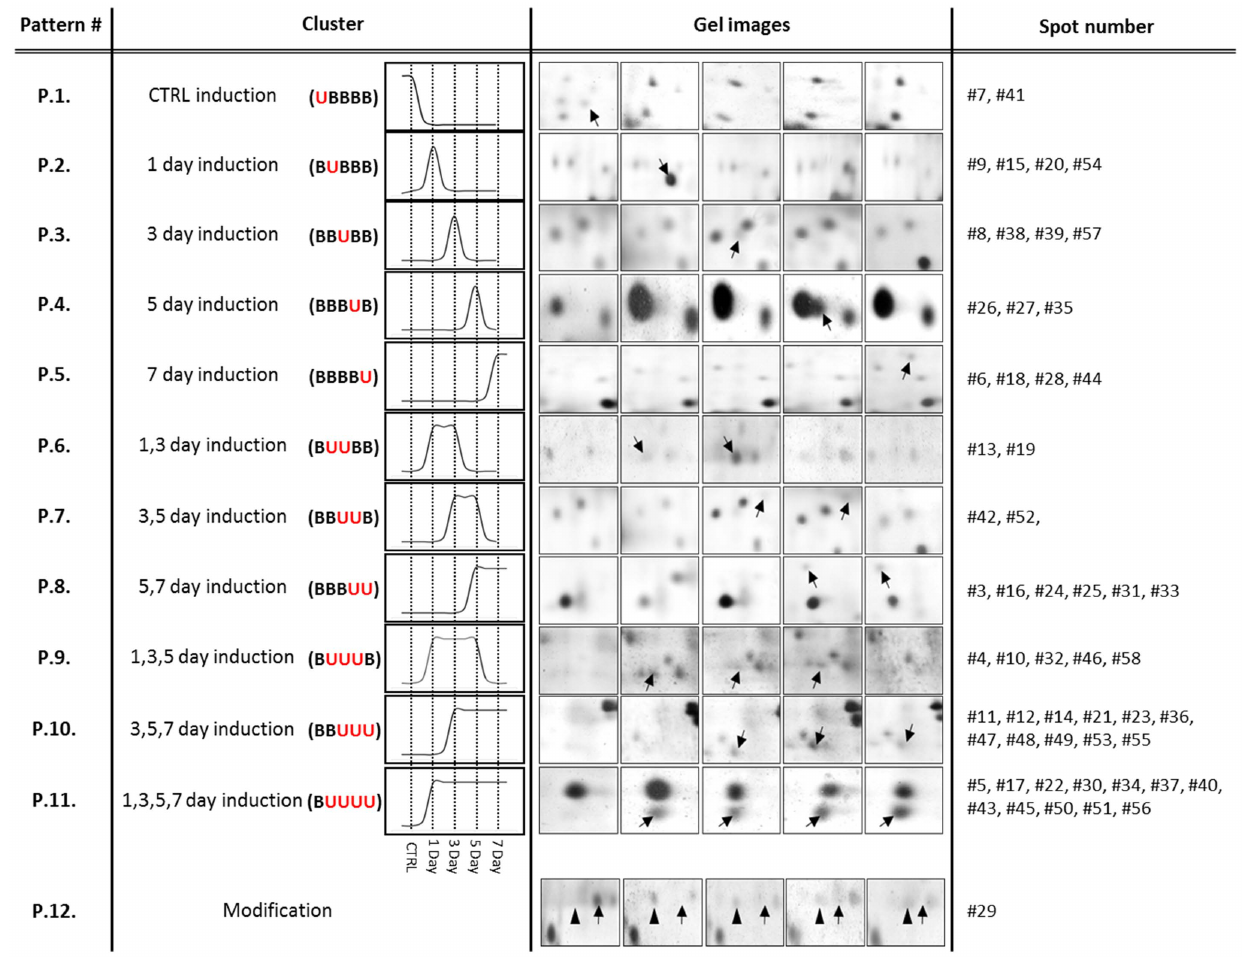
Figure 4. Categorization of 58 spots based on temporal expression profiles. Fifty-eight spots were grouped based on their temporal expression patterns following spot analysis for each time point (B: basal expression; U: up-regulation; M: modification). All identified spots in 2-DE gel are categorized into 12 patterns based on their expression profiles (p , 0.05, one-way ANOVA). The examples of spots corresponding to the expression pattern or profile were shown. Black arrows indicate up-regulated spots at each time point. In the pattern # 12, black arrows indicate spot was shifted into a different pH location on gels as the culture progresses. Arrowheads indicate increased expression of the same protein during co- culture.